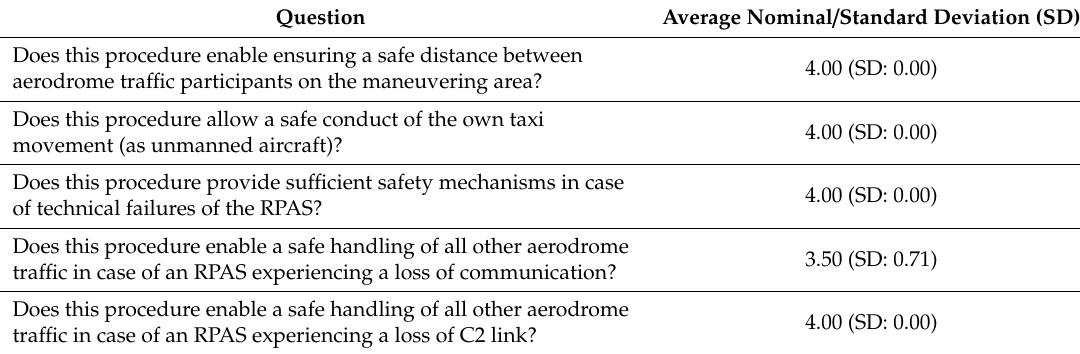
Table 6. Results of tailor-made questionnaires related to safety in non-nominal situations (loss of command and control link, and loss of communication), answered by RPAS